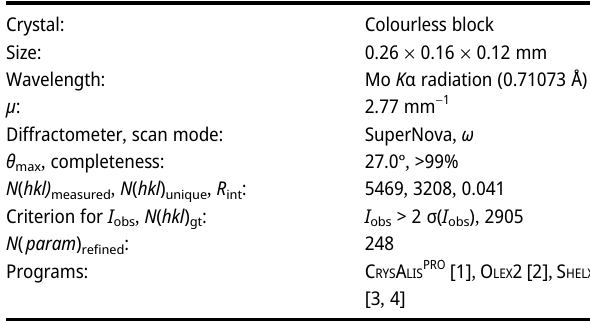
Table 1 contains crystallographic data and Table 2 contains the list of the atoms including atomic coordinates and displacement parameters.